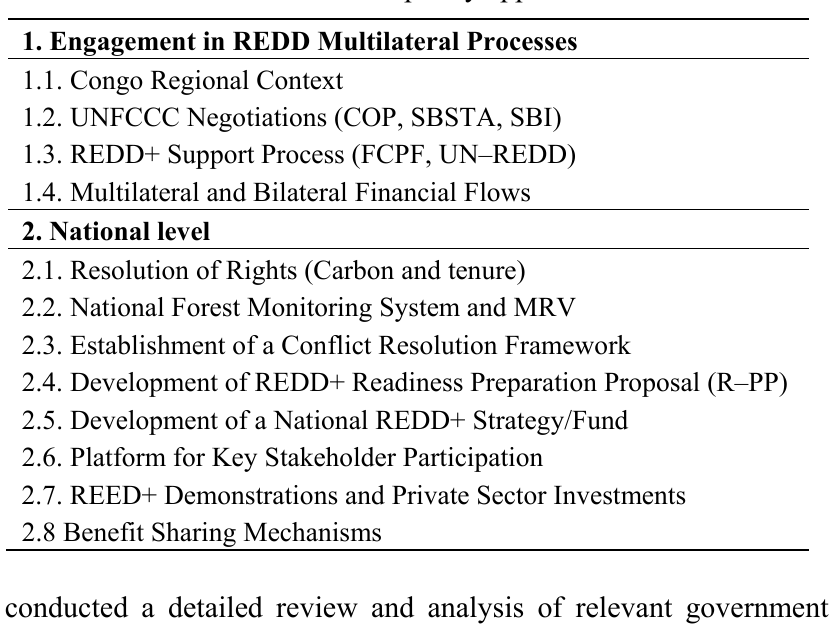
Table 2. Assessment criteria for REDD+ policy approaches in Cameroon and